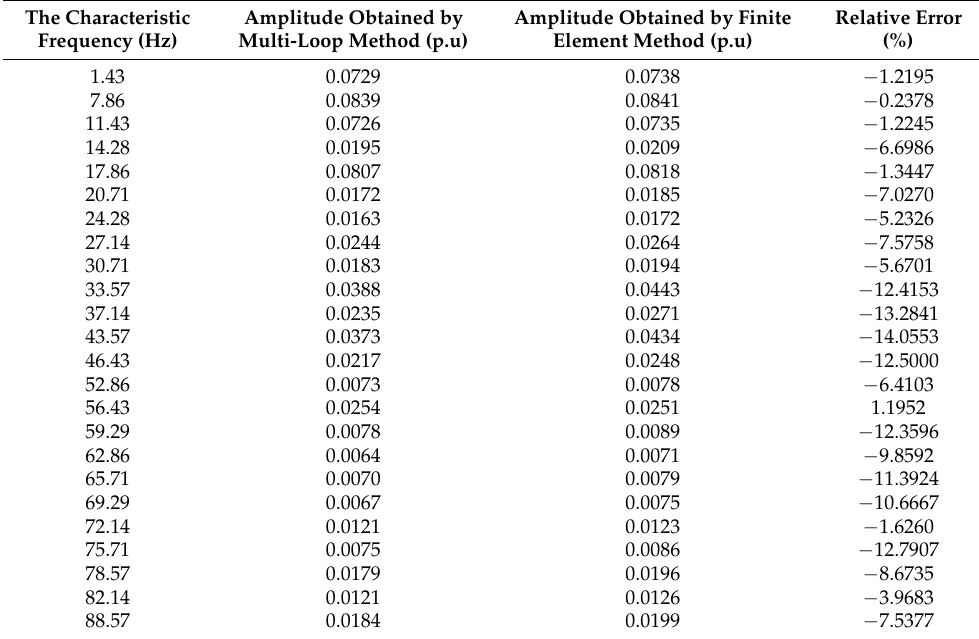
Figure 7. Spectrum diagram of the circulating current of phase A obtained by finite element method. Table 3. Characteristic frequency amplitude obtained by multi-loop simulation method and finite element simulation method.